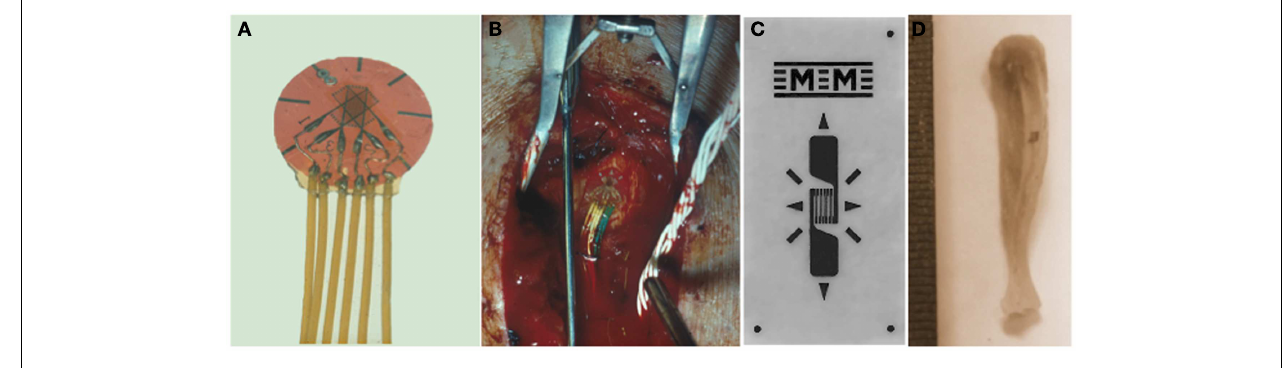
of activities and also to match experimental groups with different bone stiffness. (B) A strain gage bonded to a human tibia and (D) to a mouse